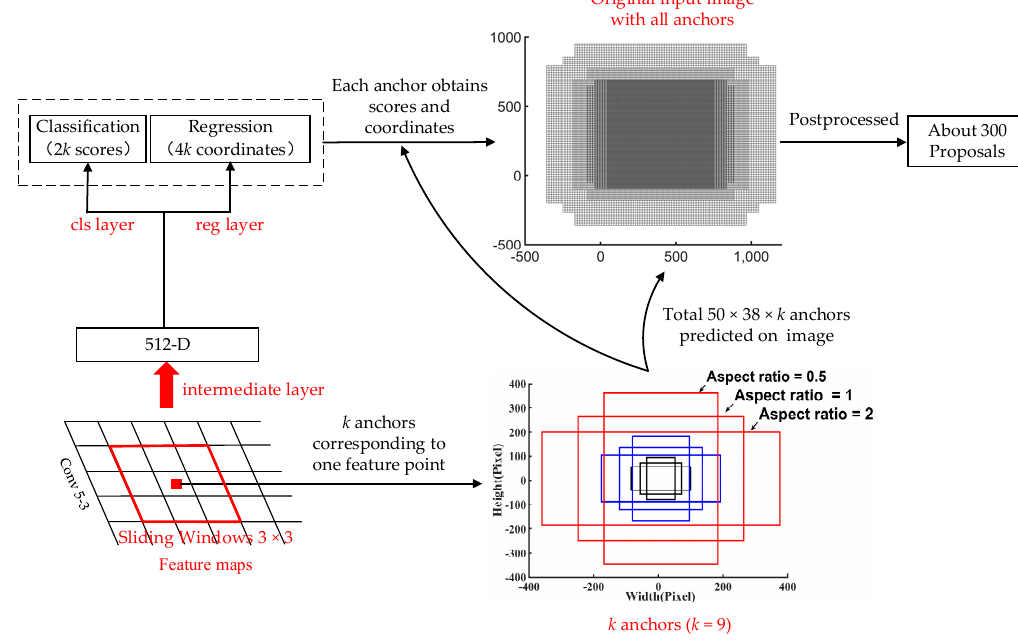
Figure 2. Region proposal network (RPN) workflow in the test phase.